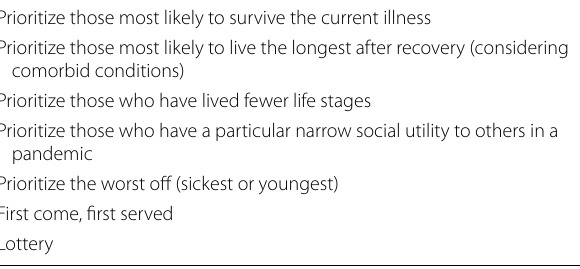
Table 1 Ethical values to justify priorities for critically ill patients